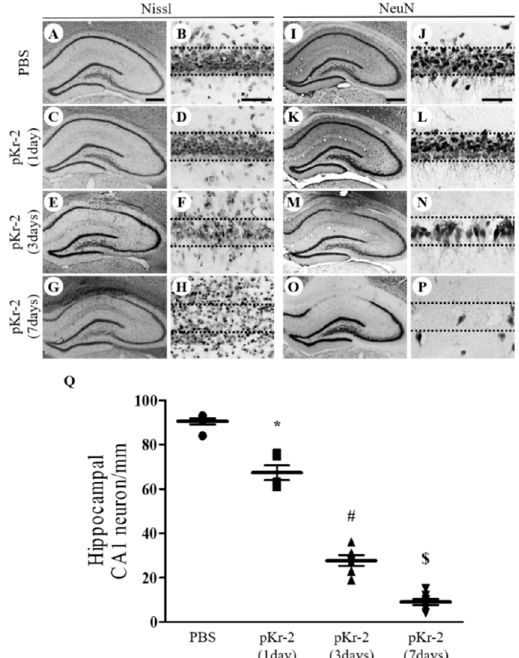
Figure 2. pKr-2-induced neurotoxicity in the CA1 layer of the hippocampus in vivo. Sections ( A , B , I , J , PBS; C – H, K – P , pKr-2) adjacent to those used in Figure 1 were processed for Nissl staining or neuronal nuclei (NeuN) immunostaining at indicated time points. ( B , D , F , H , J , L , N and P ) show higher magnifications of ( A , C , E , G , I , K , M and O ), respectively. ( A – H ) CA1 layer of the hippocampus stained for Nissl substance (cresyl violet). Scale bars, 500 µ m ( A , C , E and G ), 50 µ m ( B , D , F and H ). ( I – P ) NeuN immunostaining in the CA1 layer of hippocampus. Scale bars, 500 µ m ( I , K , M and O ), 50 µ m ( J , L , N and P ). ( Q ) Quantification of NeuN + cells in the CA1 layer of pKr-2-injected hippocampus. * p < 0.001, significantly different from PBS. # p < 0.001, significantly different from pKr-2 (1day). $ p < 0.001, significantly different from pKr-2 (3days). mean ± SEM; n = 5 to 7 in each group, ANOVA and Newman–Keuls analysis.